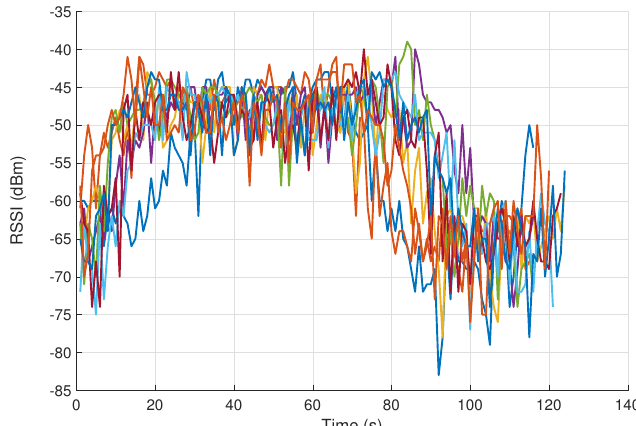
Figure 4. RSSI signals in dBm measurements associated with elbow scratching (10 different signals representing the same hand movement kind).